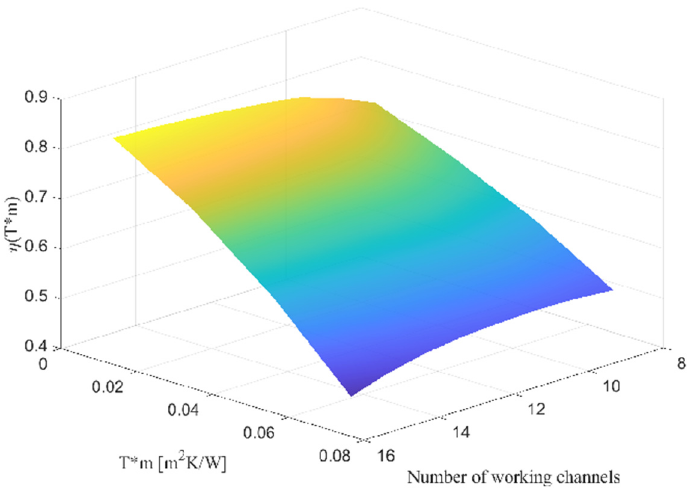
Figure 8. Characteristic curve of (cid:2015)((cid:1846) ∗ (cid:1865)) as a function of the number of working pipes.